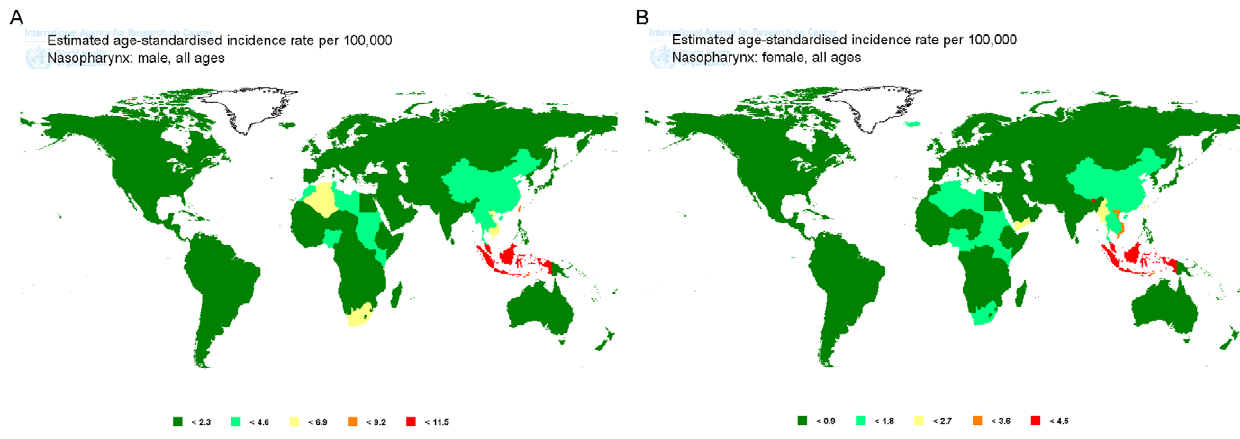
Figure 2. GLOBOCAN2008 map for global NPC incidence in male (A) and female (B). Demonstrated as ASR per 100,000 people-years.